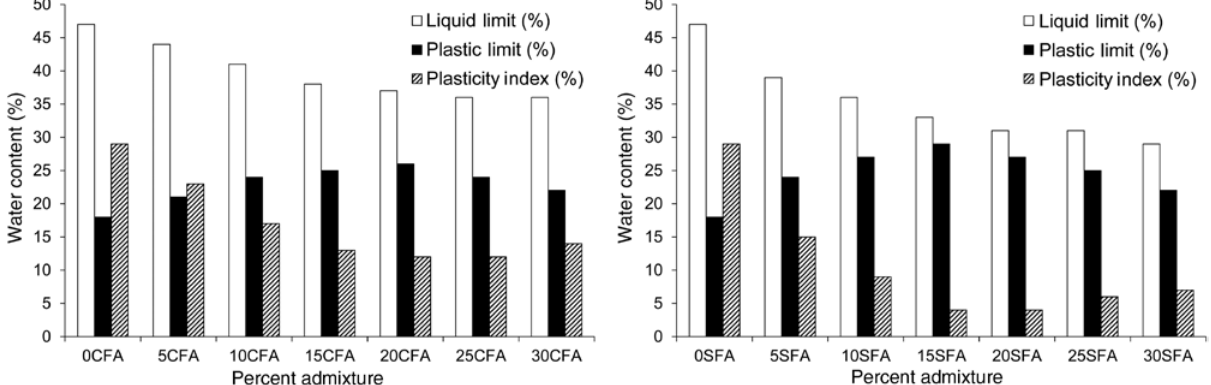
Figure 5: Effect of Catalagzi and Soma fly ash on consistency limits of Soil B.